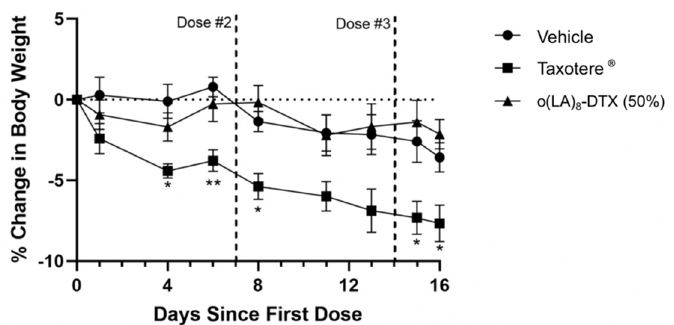
Figure 8. Body weights of PC3 and LNCaP tumor-bearing nude mice following first treatment with vehicle, Taxotere ® , or o(LA) 8 -DTX (50%) (n = 5 or 6; mean ± SEM). While Taxotere ® mice lost a significant amount of weight relative to the control group, there were no significant differences between vehicle- and o(LA) 8 -DTX (50%)-treated mice. * p < 0.05; ** p < 0.01.